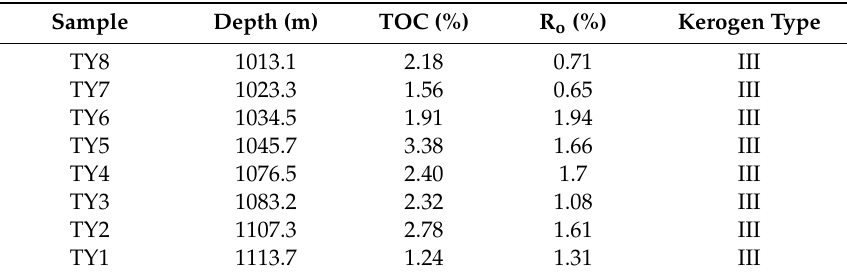
Table 1. Partial geological parameters of the Taiyuan marine shale samples. TOC: total organic content.